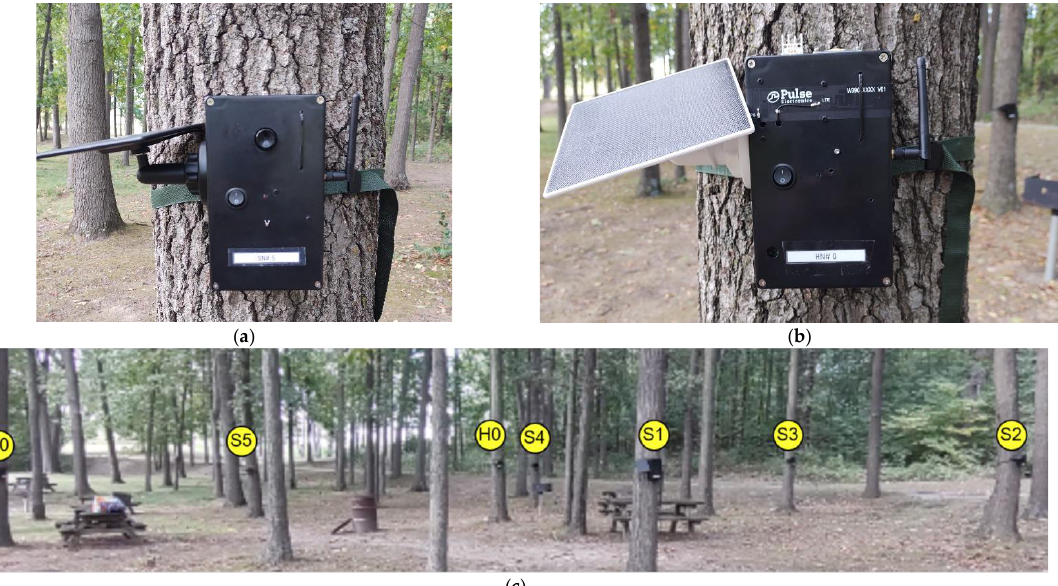
Figure 12. Photograph of testing the system in forest environment: ( a ) a sensor node tied to a tree; ( b ) the hub node tied to a tree; ( c ) shows all nodes — six sensor nodes marked from S0 to S5 and one hub node marked as H0.